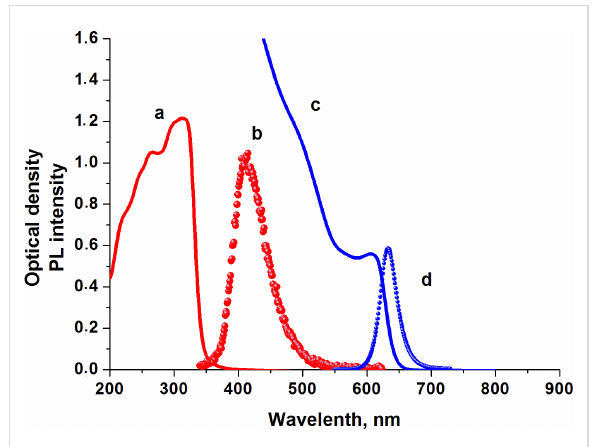
Figure 1: Absorption (solid lines) and luminescence (dotted lines) spectra of (a,b) a nematic liquid crystal and (c,d) CdSe/ZnS quantum dots core diameter of 5 nm. The excitation wavelength is 320 nm.